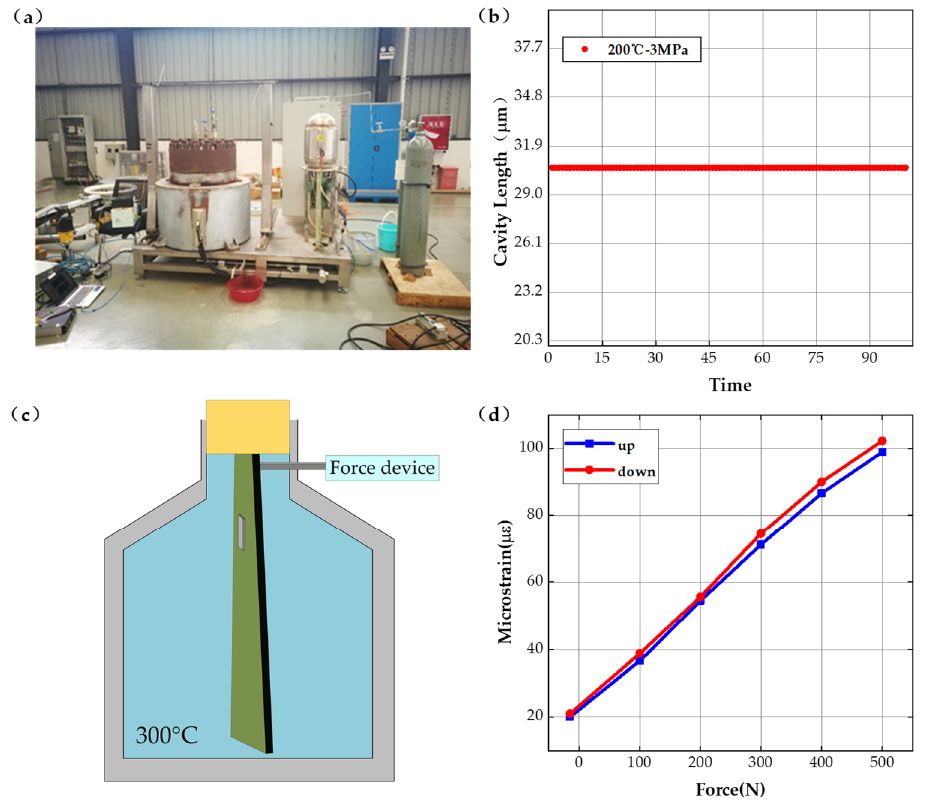
Figure 5. High-temperature experiments. ( a ) Temperature fatigue experimental system, ( b ) temperature fatigue experimental results, ( c ) schematic diagram of high-temperature loading experimental system, and ( d ) high-temperature loading experimental results.